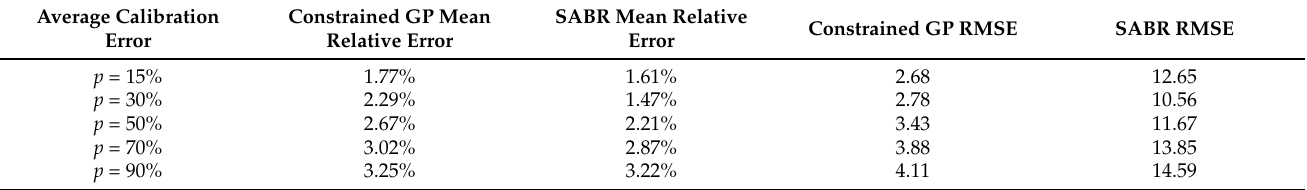
Table 6. Mean relative calibration error and calibration RMSE of the constrained GP regression and SABR model with barycentric mean parameter interpolation, for increasing sizes of training